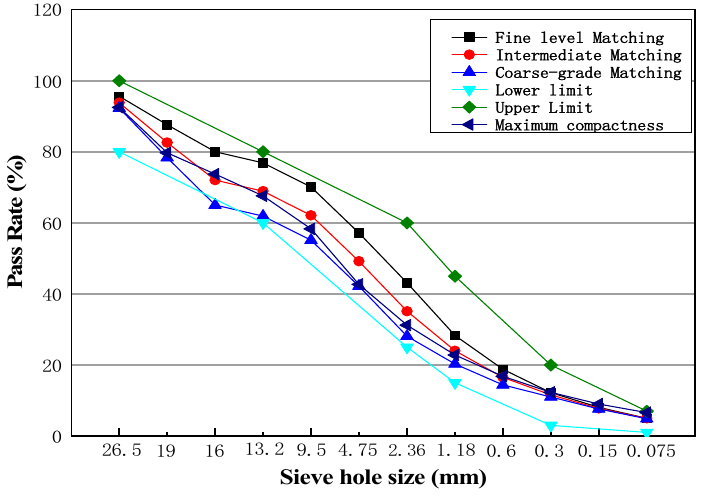
Figure 3. Design gradation curve.